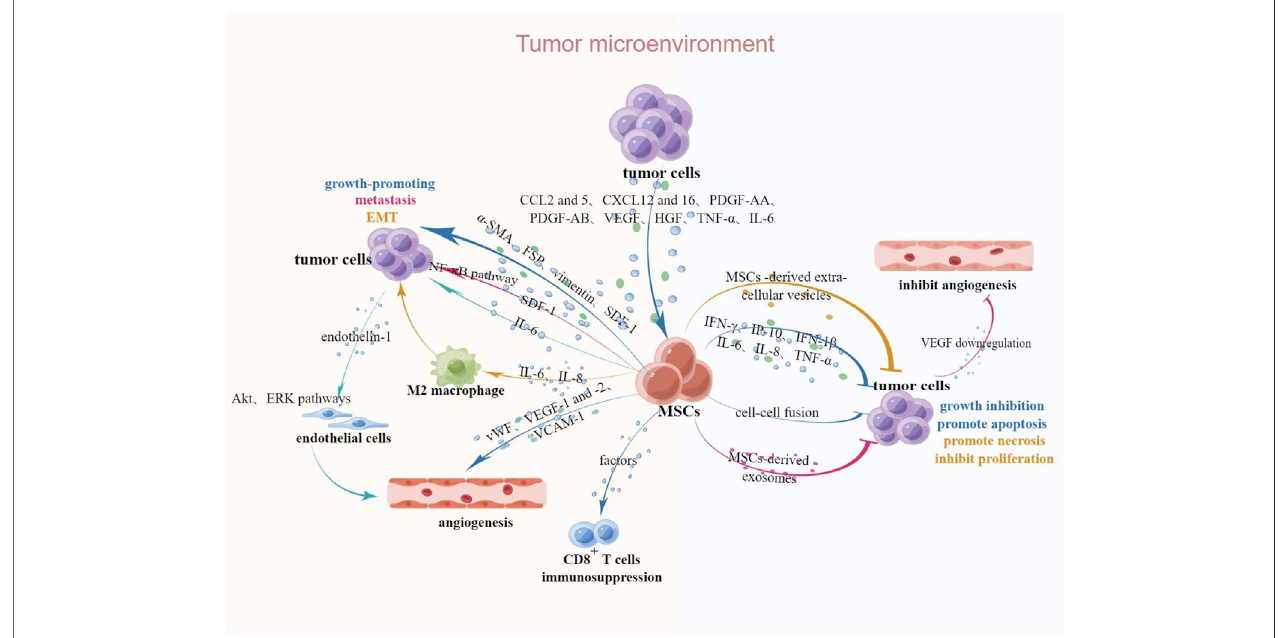
FIGURE 1 | Interactionbetween MSCsand tumorsinTME.Upon tumorigenesis, tumorssecrete relevant chemokines, cytokines and growthfactors toattractMSCs, after which MSCs undergo a series of phenotypic and functional changes and secrete relevant bioactive factors to act on neighboring cells, thus exerting tumor-promoting orsuppressiveeffects.Abbreviations:CCL2and5,CC-chemokineligands2and5;CXCL12and16,chemokineligands12and16;HGF,hepatocytegrowthfactor; α -SMA, α -smooth muscle actin; FSP, fi broblast surface protein; SDF-1, stromal-derived factor 1; IP-10, IFN- γ -inducible protein 10. This fi gure was created by using